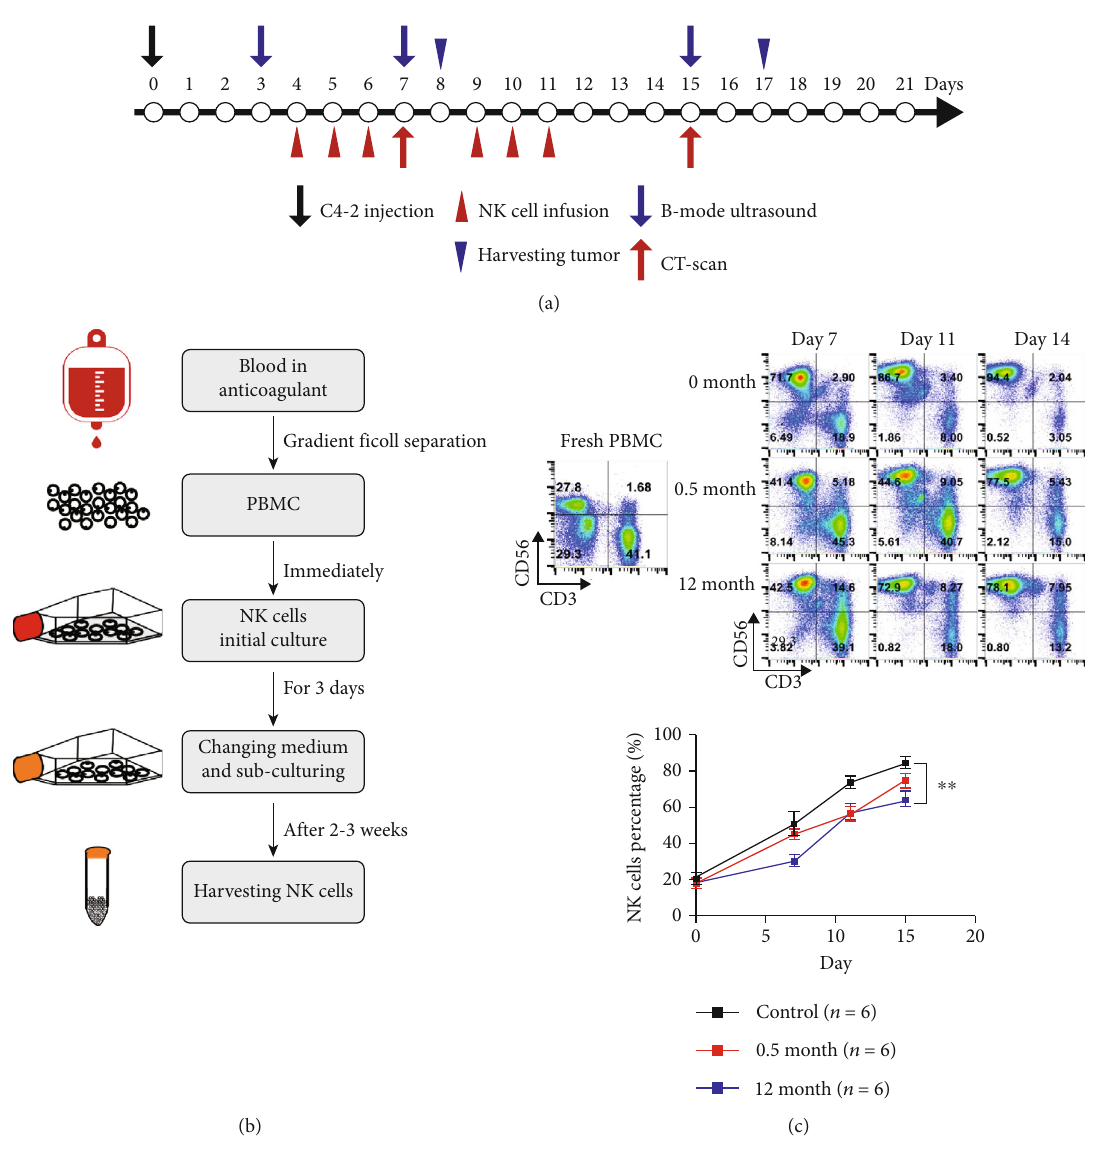
Figure 1: The in vivo experiment arrangements and NK cell production with validation. (a) Time schedule for in vivo experiment. The mice were subcutaneously injected with C4-2 cells on day 0 and randomly grouped into treatment and control groups ( n = 12 in each group). Treatment started on day 4 and contained 2 cycles: days 4 – 6 for the fi rst cycle and days 9 – 11 for the second cycle. The ultrasonography was performed on days 3, 7, and 15, and Micro-CT scan was performed on days 7 and 15 to evaluate the tumor size change. On day 8, six mice in each group were randomly chosen and killed after the fi rst cycle of treatment. The remaining six living mice in each group continued to accept the second cycle of treatment and were sacri fi ced on day 17. (b) Overview of the steps leading from human blood to peripheral blood NK cells. NK cells e ffi ciently di ff erentiate and expand in culture and could be harvested in 2 – 3 weeks. (c) Representative fl ow cytometry plots and summary data ( n = 3 ) of NK and T cell percentages. NK cells (CD3 − CD56 + ) and T cells (CD3 + CD56 − ) account for 27.8% and 41.1% in fresh PBMC, respectively; on days 7, 11, and 14 after culture, the NK cells (CD3 − CD56 + ) account for 71.7%, 86.7%, and 94.4% in expanded fresh cells, respectively. The 0.5 month cryopreserved NK cells after days 7, 11, and 14 culture account for 41.4%, 44.6%, and 77.5%, respectively, and the 12 month cryopreserved NK cells after days 7, 11, and 14 culture account for 42.5%, 72.9%, and 78.1% after being thawed, respectively. There is signi fi cant di ff erence between the fresh NK cells and thawed 12 month cryopreserved NK cells in NK cell percentages ( n = 6 independent expansions from 6 healthy donors). Values are expressed as the means ± SD , ∗∗ p < 0 : 01 . PBMC: peripheral blood mononuclear e ff ects could be observed at E / T of 2.5 : 1 and reached a peak